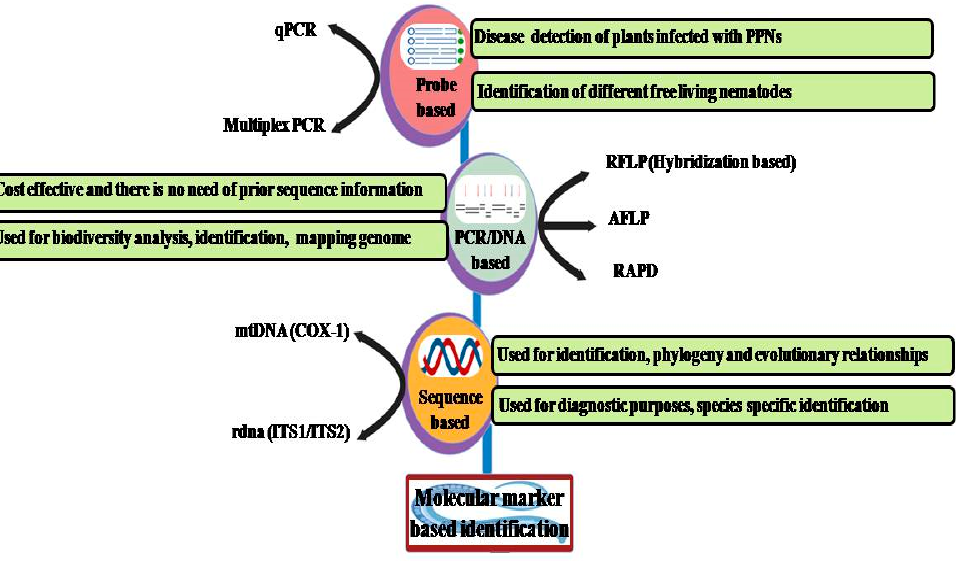
Figure 3. Different molecular markers for the identification of nematodes based on probe-, DNA-, and sequence-based methods.